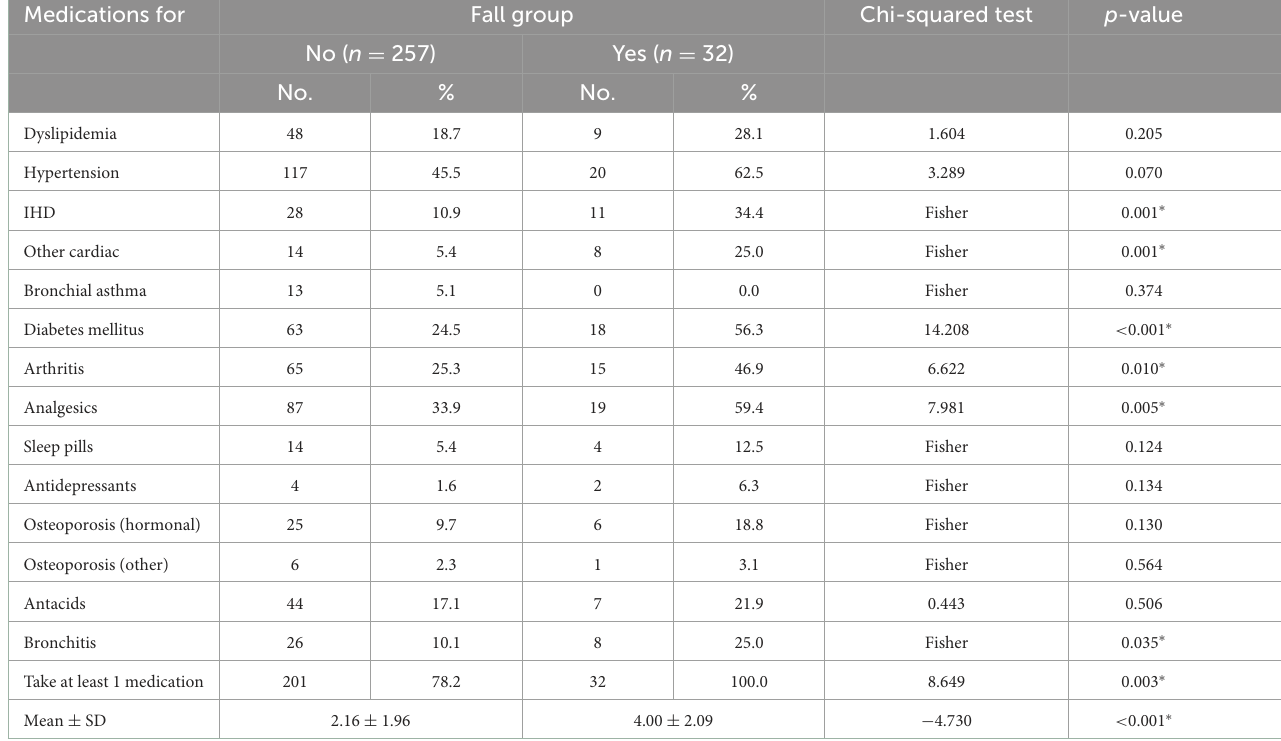
TABLE 5 Comparison of the administration of medications as reported by old age persons with and without fall